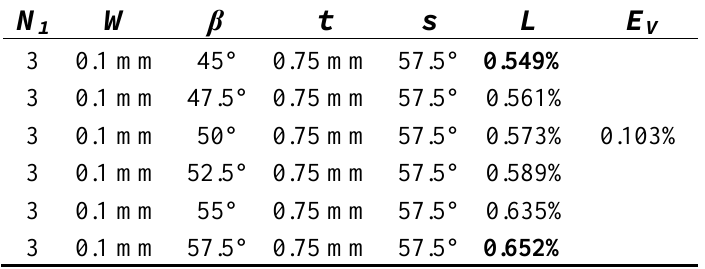
Table 6. Nonlinearity errors of the sensors with different loop angles.